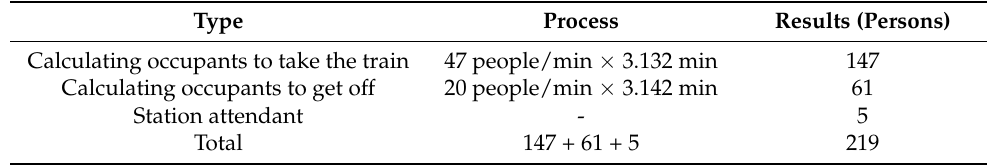
Table 2. Number of passengers in the station.